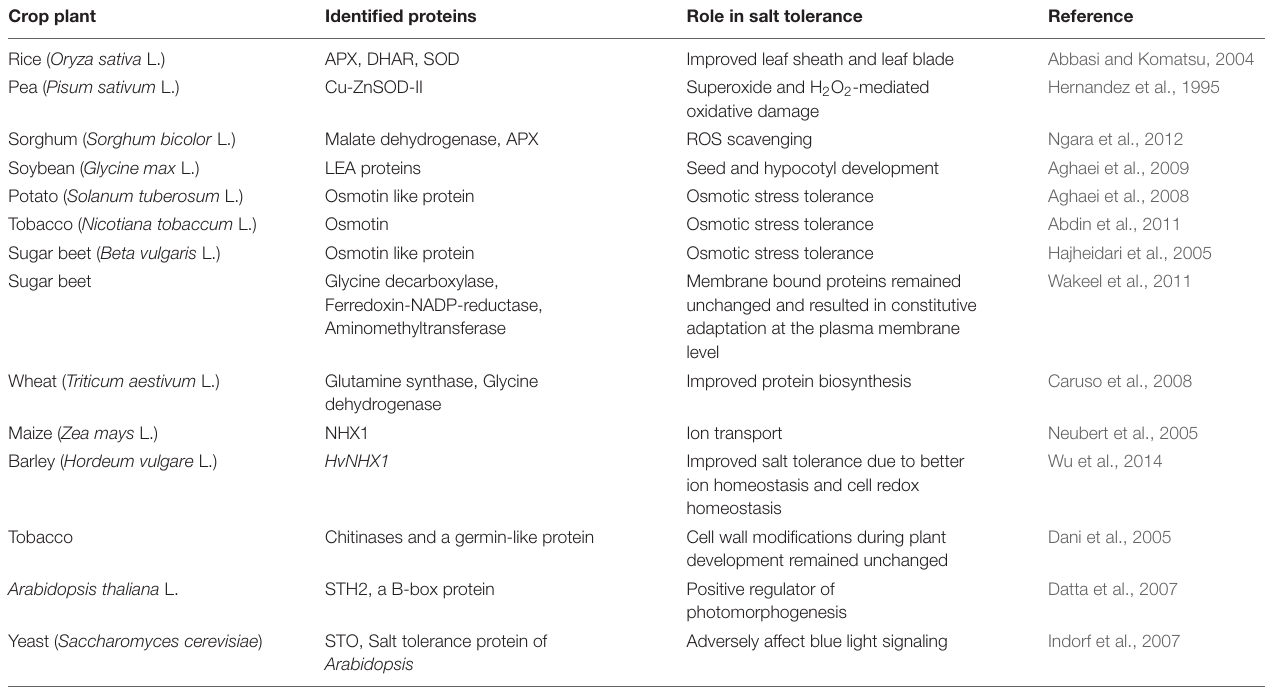
TABLE 1 | Identification and specific roles of different proteins in salt tolerance. Crop plant Identified